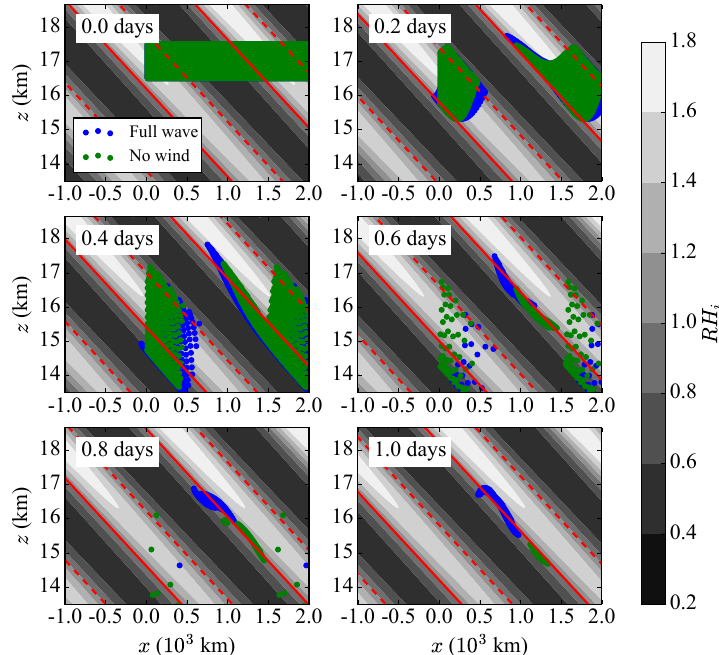
= 85%. Different integration times are Figure 5. Simulations of ice crystal growth and sedimentation in an idealized wave field at RH i c displayed, up to half a wave period, i.e., 1 day. The black and white background represents the RH i spatial variability and the colored dots correspond to the position of the ice crystals. The different colors correspond to simulations with different processes (un)accounted for: the blue dots represent the ice crystals’ positions for the full simulation (wave advection and temperature fluctuations), whereas for the green dots both the horizontal and vertical winds induced by the wave have been neglected. The solid and dashed red lines respectively correspond to the locations of the elliptic and saddle points; for both of those RH i = 100%. The initial ice crystal radius used for all crystals is 5µm.